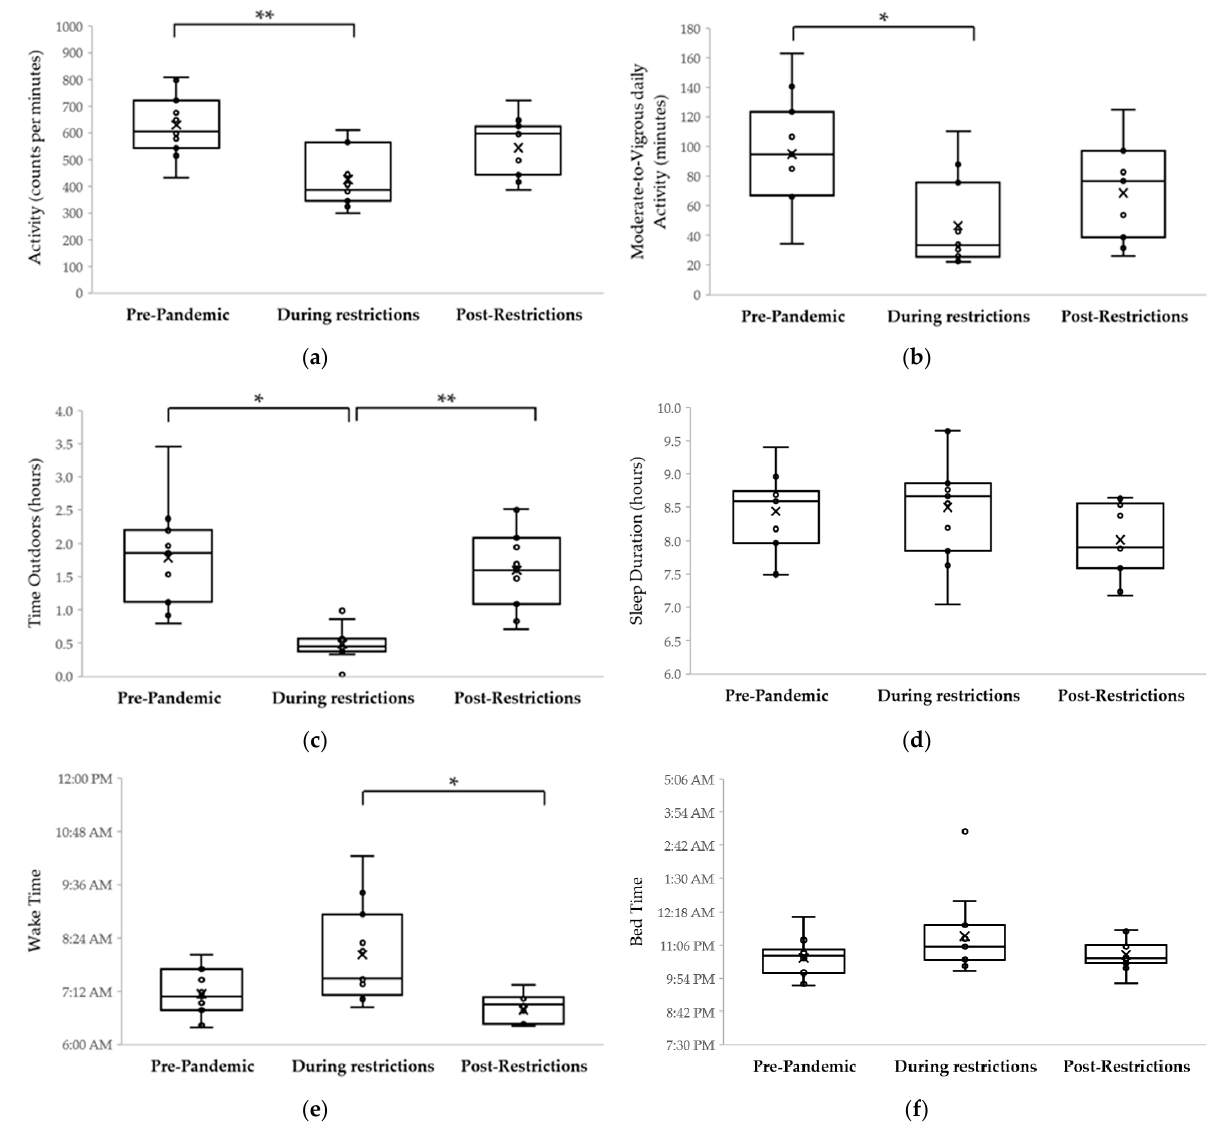
Figure 2. Plot illustrating different behaviors pre-pandemic, during restrictions and post-restrictions: ( a ) Mean daily physical activity (from 7:00 a.m. to 4:30 p.m.); ( b ) Mean moderate-to-vigorous daily physical activity (from 7:00 a.m. to 4:30 p.m.); ( c ) Mean daily time outdoors (from 7:00 a.m. to 4:30 p.m.); ( d ) Mean daily sleep duration (hours); ( e ) wake time; ( f ) bedtime. Pre-pandemic (black bars), during restrictions (gray bars), and post-restrictions (white bars) ( n = 11); Solid horizontal line indicates the median, and the box extends between the 25th and 75th percentile of the data, and the whiskers extend to the smaller of the full range or 1.5 times the interquartile range of the data. * p < 0.05 and ** p < 0.001 for post-hoc pairwise test with Bonferroni correction between sessions.